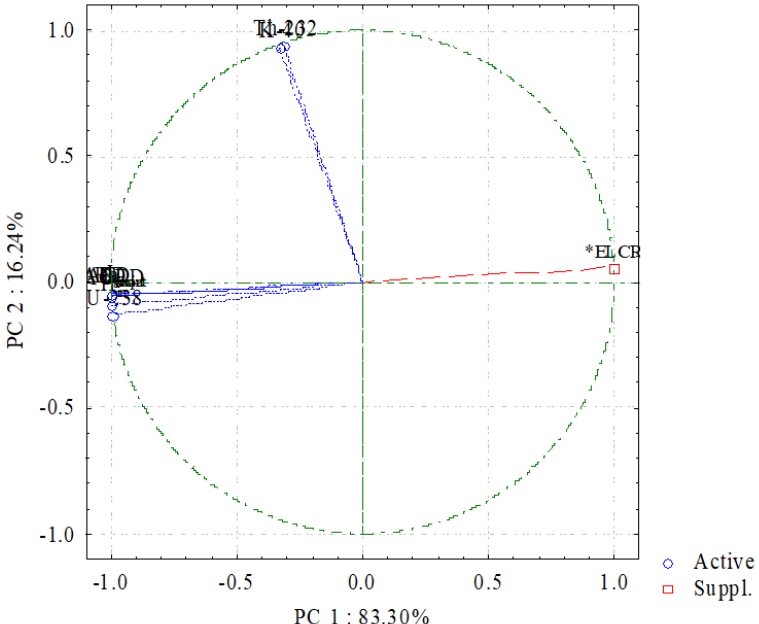
Figure 11. Principal component analysis (PC1 and PC2) of radiological data for GR at the Sol Hamed area.